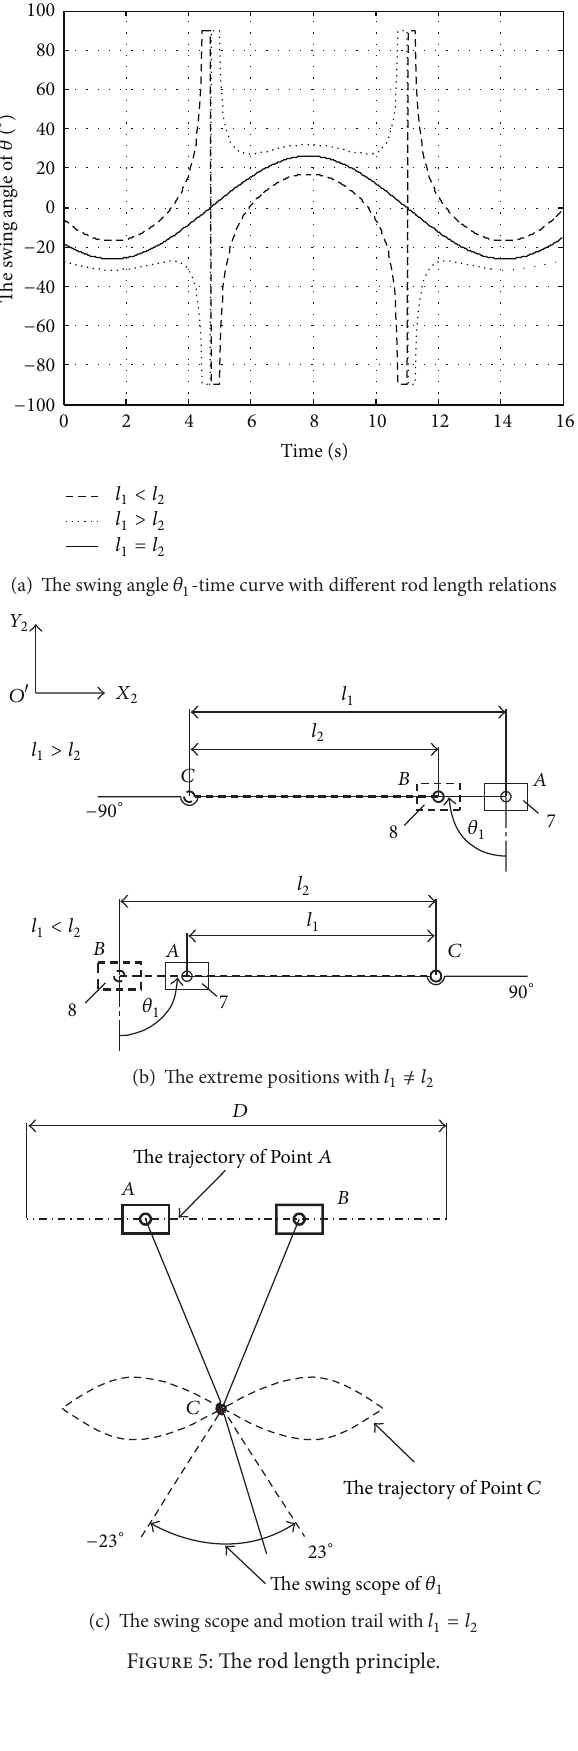
Figure 5: The rod length principle.